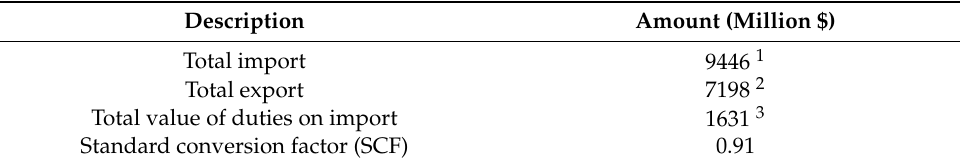
Table 8. Standard conversion factor calculation.